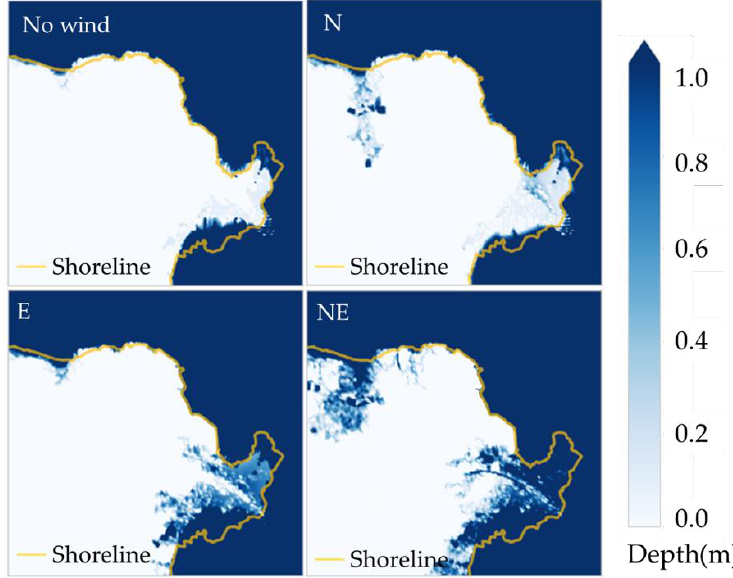
Figure 8. Different wind directions in the inundation area for the 36th hour of the 50-year return period, with windless conditions as a control.